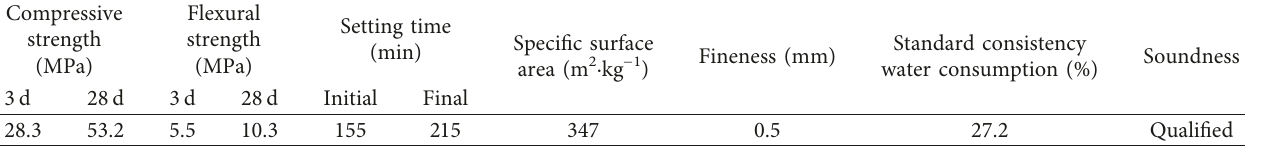
Table 1: Main properties of reference cement.